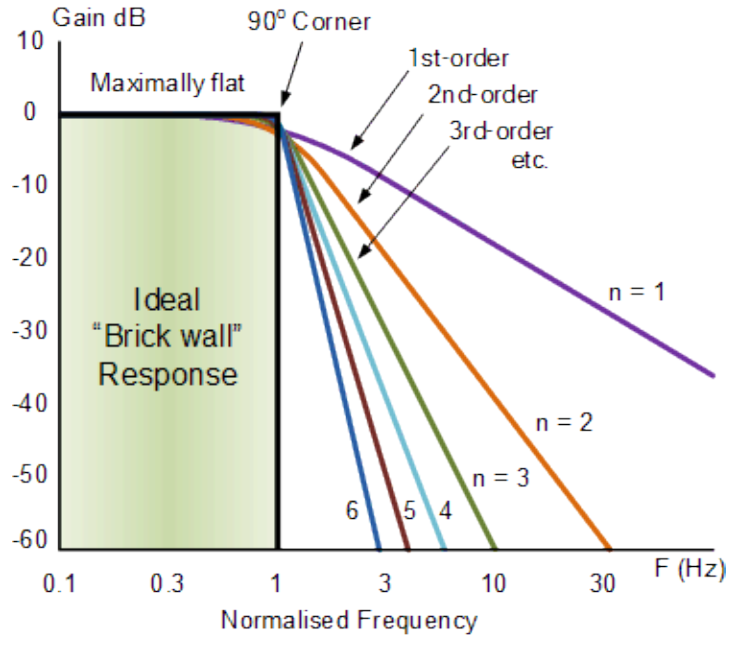
Figure 6. Butterworth filter’s ideal response